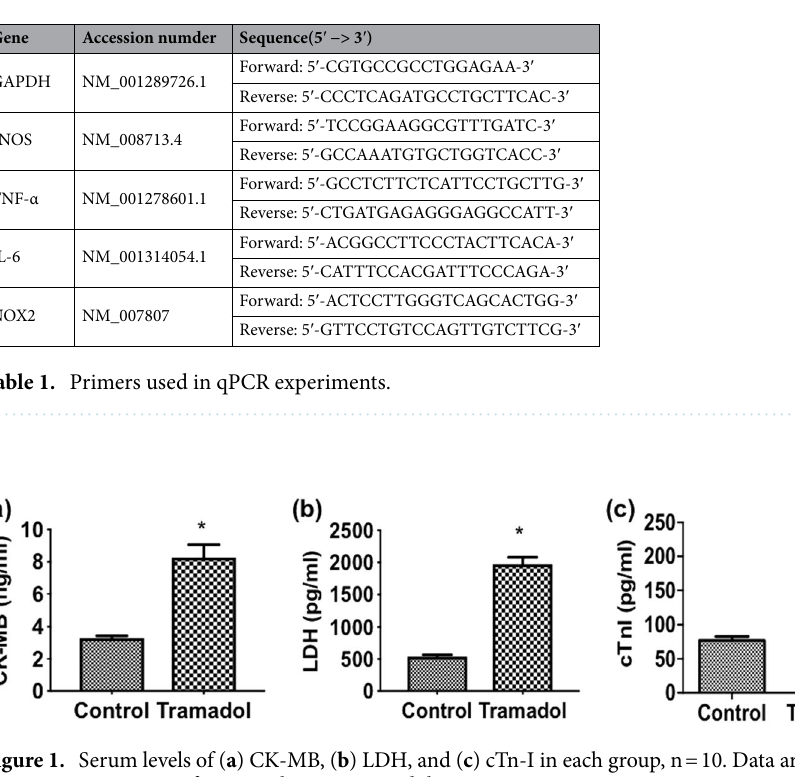
Figure 1. Serum levels of ( a ) CK-MB, ( b ) LDH, and ( c ) cTn-I in each group, n = 10. Data are expressed as means ± SEM, *p < 0.05 for control versus tramadol.